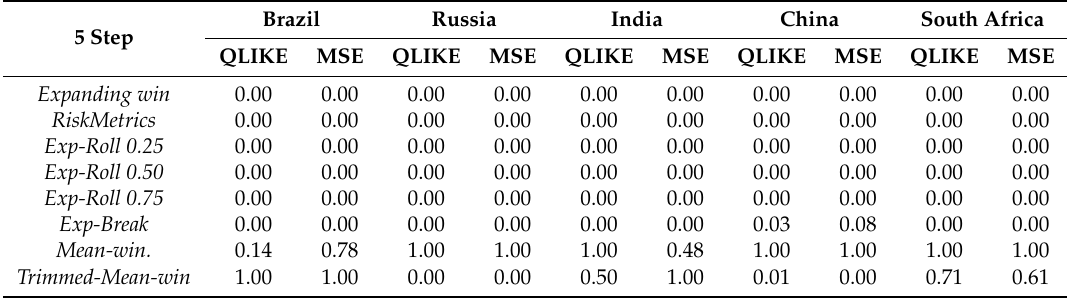
Table 5. MCS p -values for MSCI daily returns on BRICS countries. The forecasting horizon is equal to 5. The test statistic is SQ . The loss functions are MSE and QLIKE.